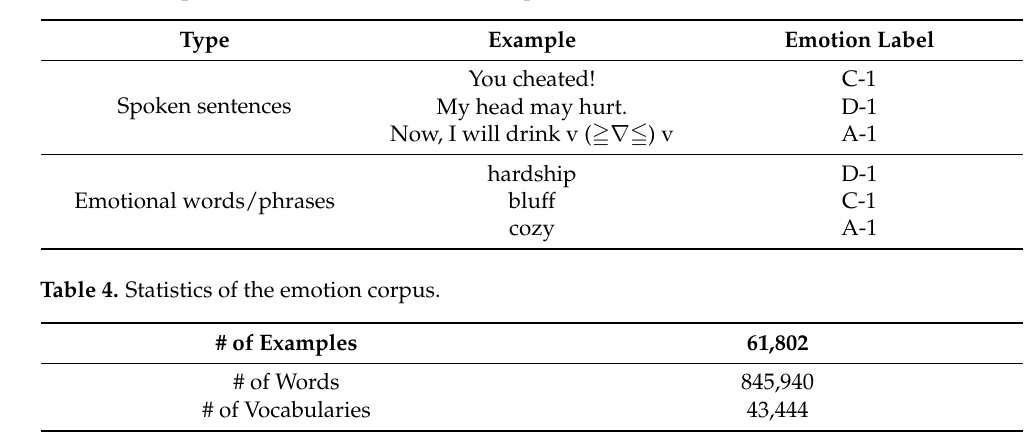
Table 3. Example of sentences in the emotion corpus.